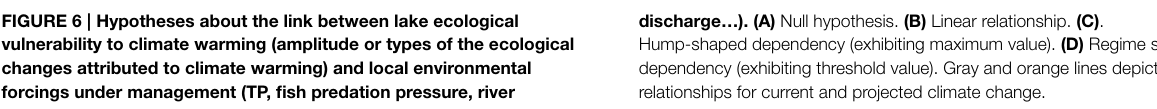
FIGURE 6 | Hypotheses about the link between lake ecological vulnerability to climate warming (amplitude or types of the ecological changes attributed to climate warming) and local environmental forcings under management (TP, fish predation pressure, river